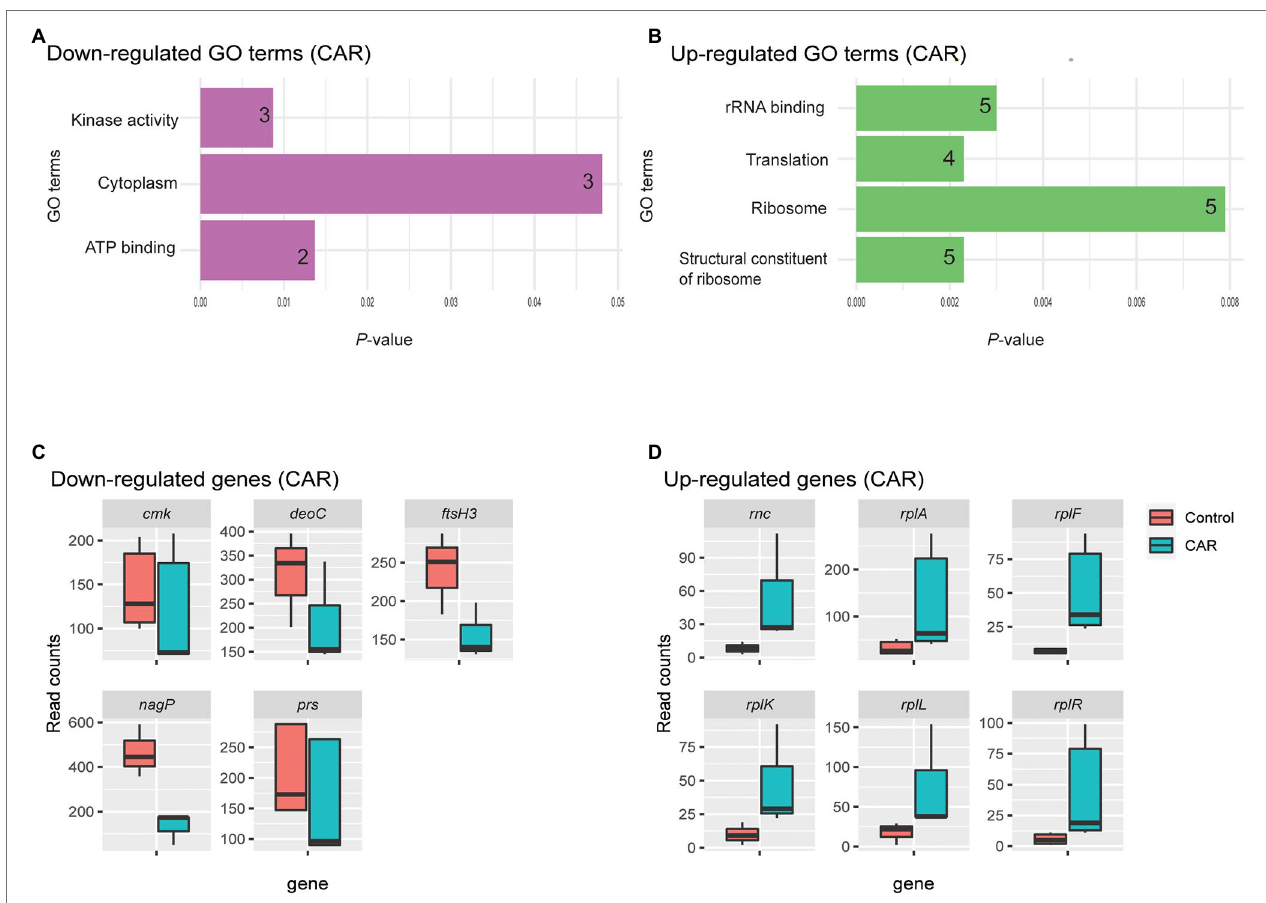
FIGURE 2 | GO analysis of down- (A) and upregulated (B) genes by CAR treatment, plotted based on p -values. The number of genes within each term is noted in the bar. Upon CAR treatment, three and four significant GO terms were found among the down- and upregulated genes, respectively. Box plots of read counts for all genes down- (C) and upregulated (D) represented by the GO terms. While each GO term was represented by a number of genes, the total number of genes for the three downregulated GO terms was five and their read counts were plotted in C. The genes are as: Cytidylate kinase ( cmk ), deoxyribose-phosphate aldolase ( deoC ), ATP-dependent zinc metalloprotease ( ftsH3 ), PTS system N-acetylglucosamine-specific EIICB ( nagP ), and ribonuclease 3 ( rnc ) and ribose-phosphate pyrophosphokinase ( prs ). Similar, six common genes represented the four upregulated GO terms plotted in D. They are ribonuclease 3 ( rnc ), 50S ribosomal protein L1( rplA ), 50S ribosomal protein L6 ( rplF ), 50S ribosomal protein L11 ( rplK ), 50S ribosomal protein L7/L12 ( rplL ), and 30S ribosomal protein S18 ( rpsR ). Gene list with respect to their Go-Term terms is given in Supplementary Table 3